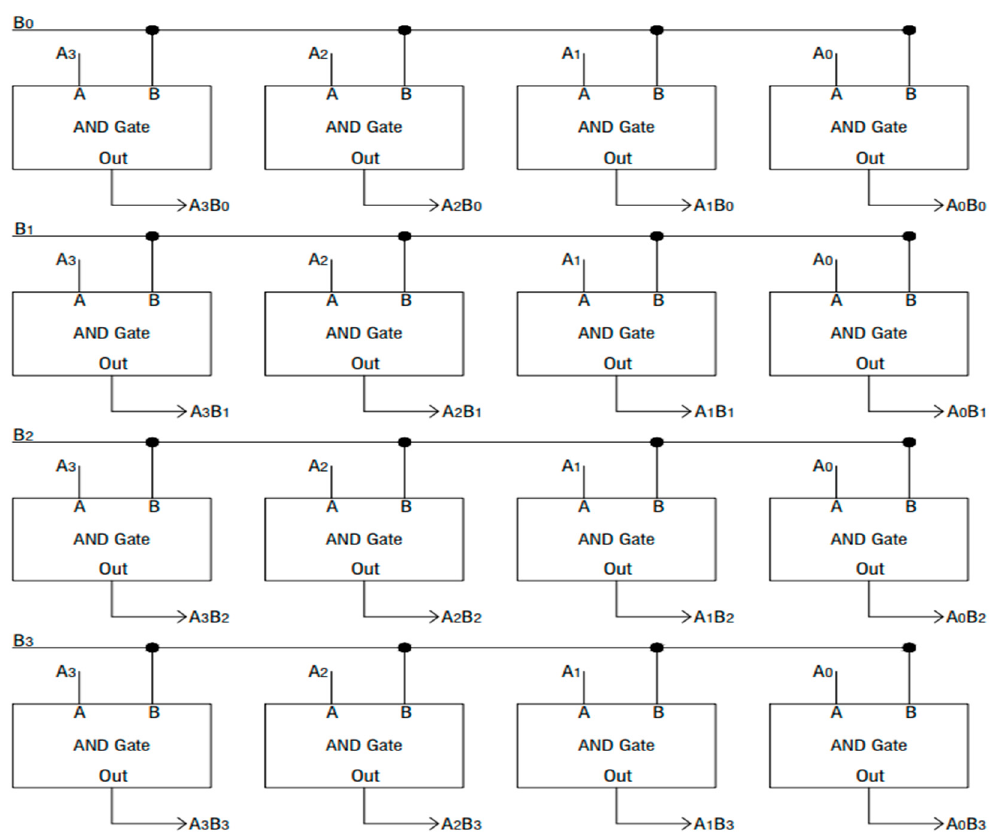
Figure 1. Schematic design of 4 × 4 partial product generator.